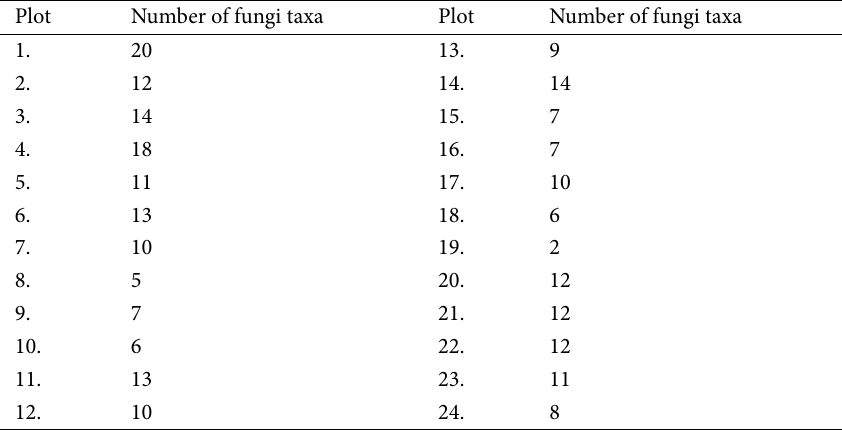
Table 2 Number of fungal taxa in the ecological groups. Ecological group of fungi Number of fungi taxa T erricolous 33 Litter-inhabiting 8 Xylobiontic 15 Bryophilous 2 Cone-inhabiting 2